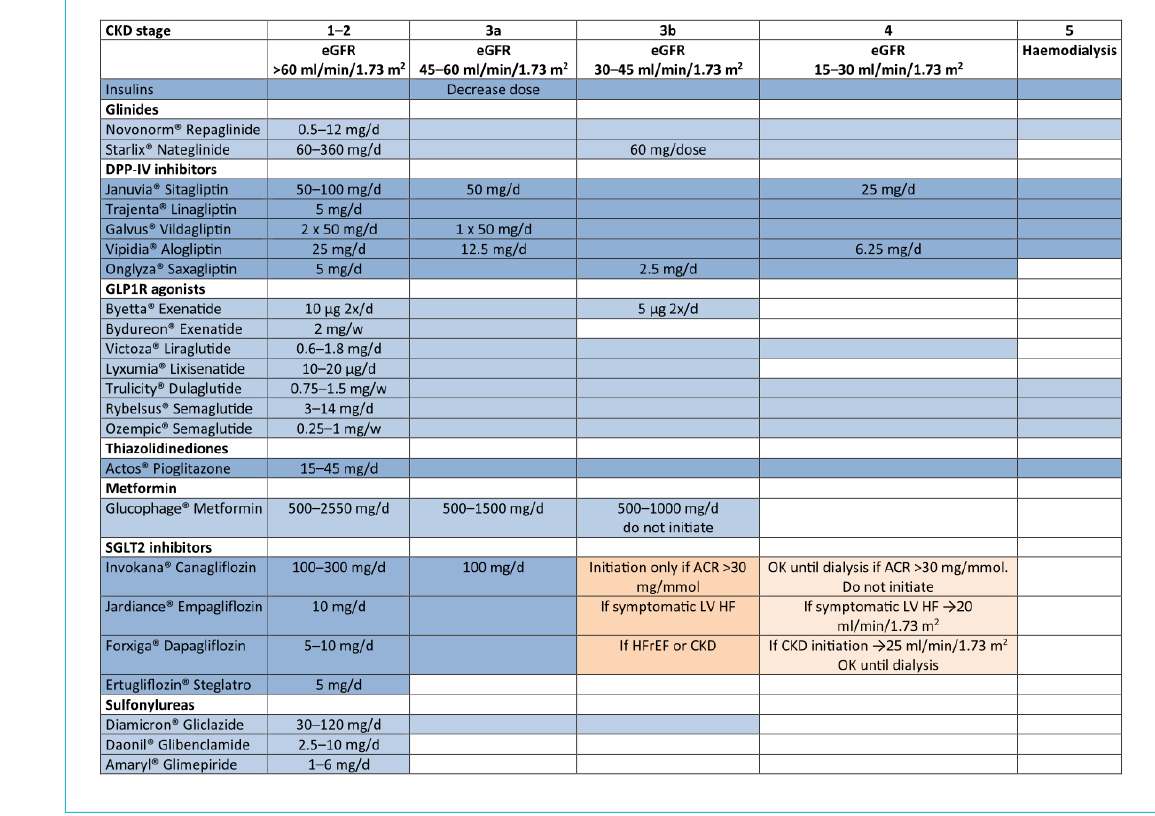
Figure 1: Adjustment of dosages according to eGFR (Swissmedic [Switzerland], for other countries refer to local